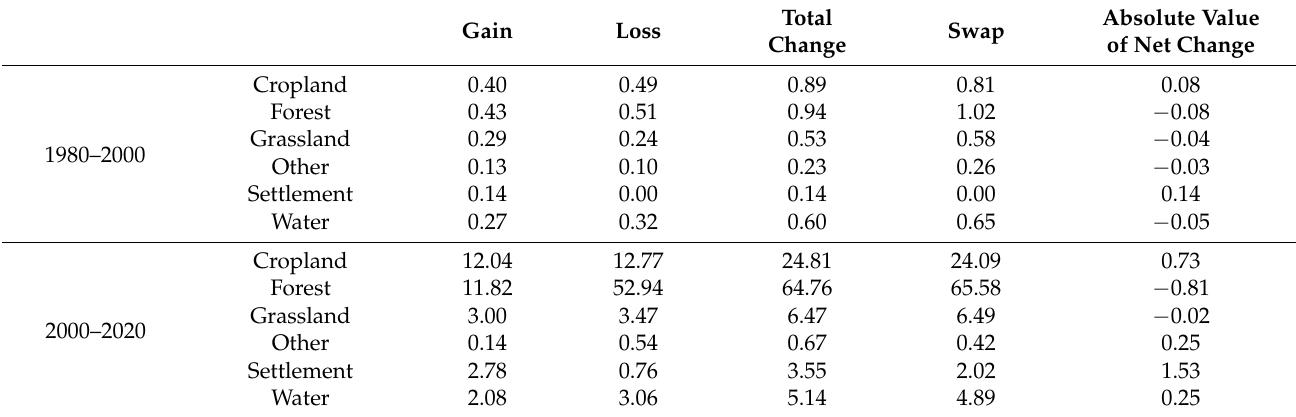
Table 2. Land use change information of 1980–2020